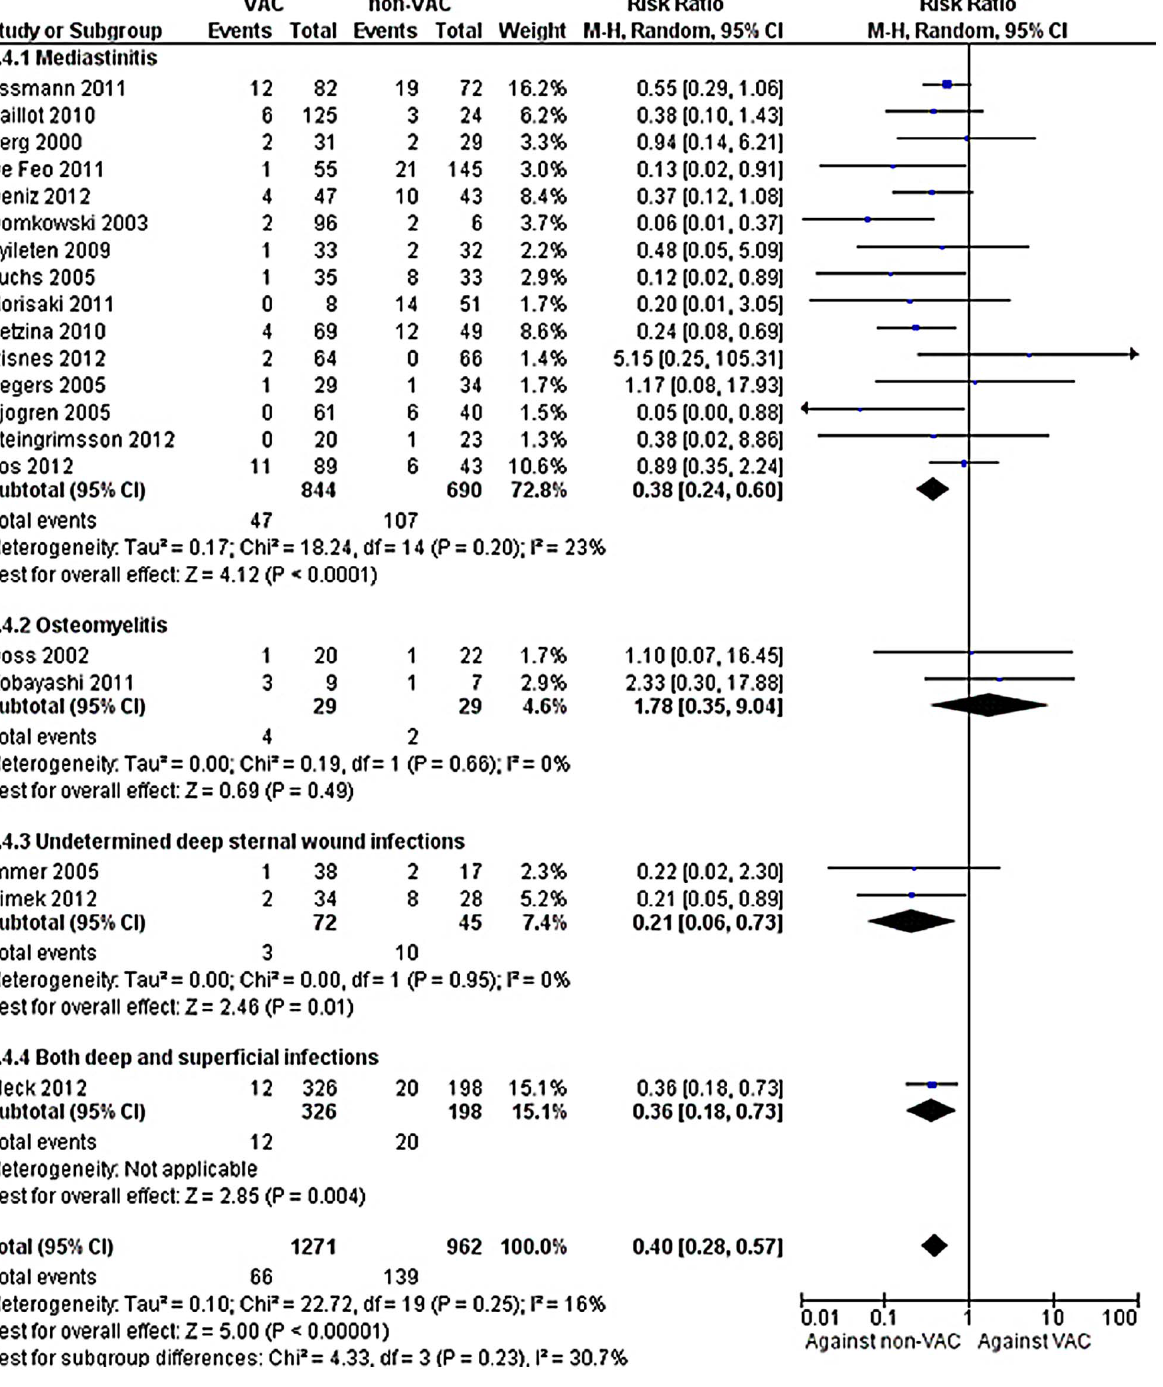
Figure 4. Forest plot depicting the risk ratios (RR) of mortality of patients according to the type of infection studied. ( Vertical line="no difference" point between the two regimens. Squares=risk ratios; Diamonds=pooled risk ratios for all studies. Horizontal lines=95% CI